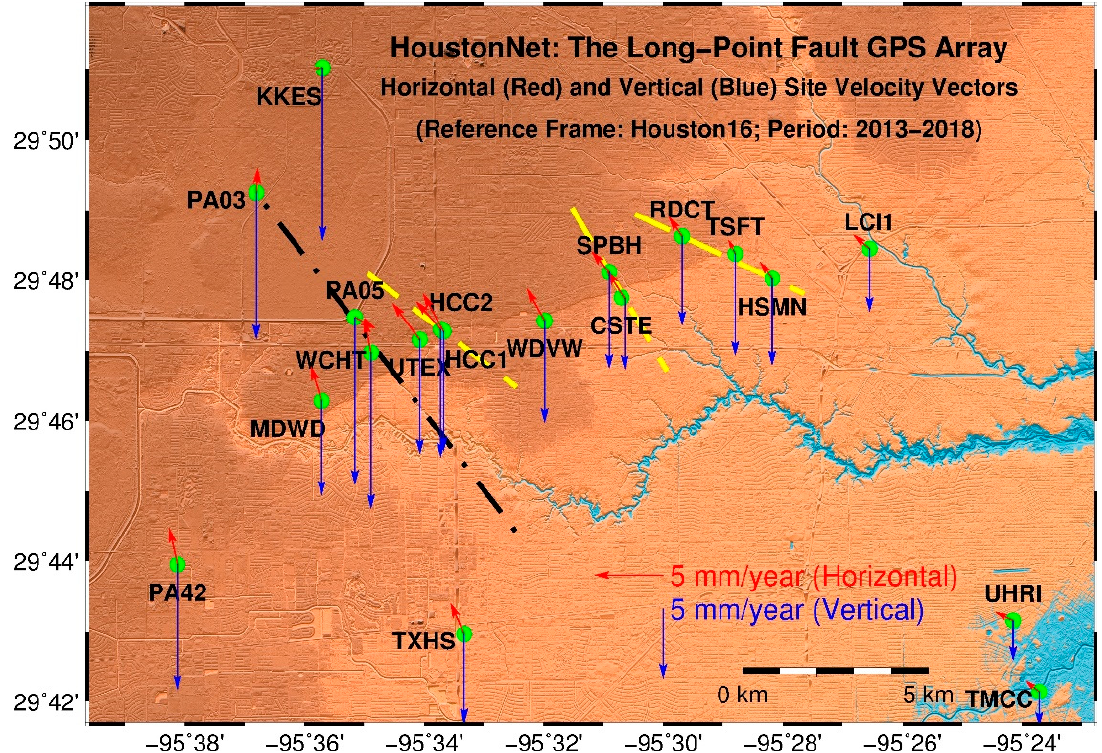
Figure 2. GPS-derived horizontal (red) and vertical (blue) site velocity vectors at permanent GPS sites along the two sides of the surface scarp of the Long Point Fault. The velocities are derived from the GPS-derived displacement time series (2013–2018) with respect to Houston16. The uncertainties (2 σ , 95% confidence level) of the velocities are ± 0.2 to ± 0.3 mm / year in the horizontal direction, and ± 0.4 to ± 0.6 mm / year in the vertical direction. The hill-shaded digital elevation model (DEM) is derived from airborne LiDAR data collected in October 2001. The yellow lines show the exact locations of three topographic profiles exhibited in Figure 4. The dark line shows the approximate location of the geological cross-section illustrated in Figure 5.